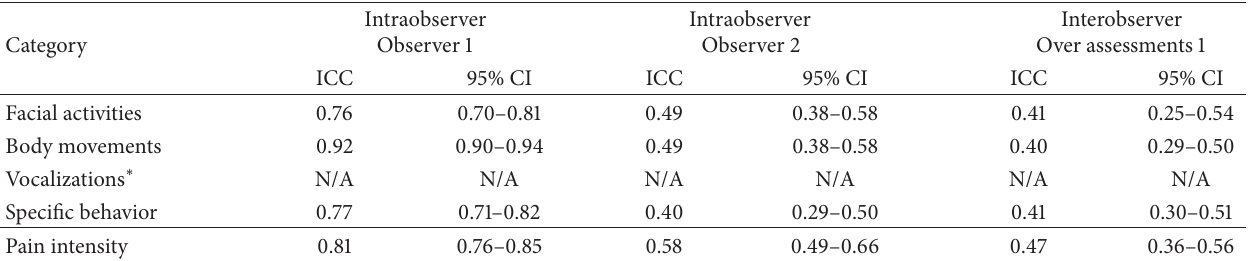
Table 4: Intraobserver and interobserver reliability for the category sum scores as well as for the estimated pain intensity scale.